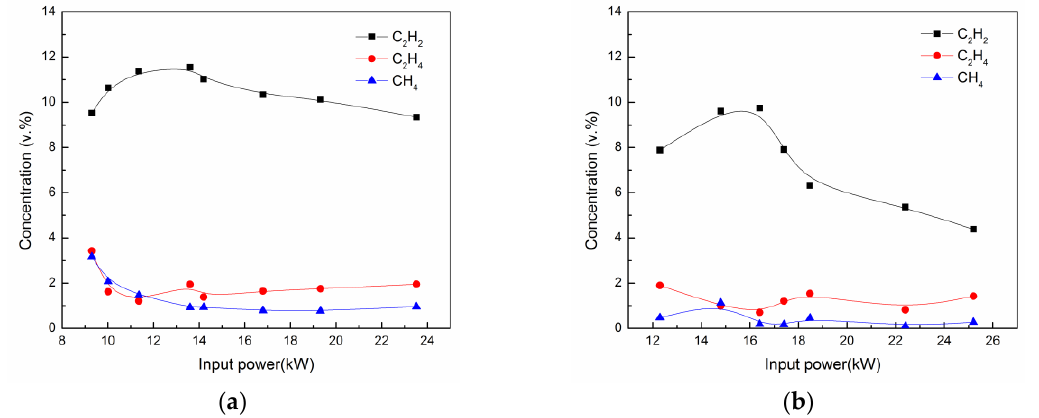
Figure 5 . The effect of power input on the concentration of C 2 H 2 , C 2 H 4 and CH 4 in the pyrolysis product of n- hexane ( a ) and toluene ( b ). Reaction conditions: ( a ) R H/C = 6.5, Q H m- n- hexane = 20.5 g/min, B = 0.058 T, P = 9.3–23.5 Kw; ( b ) R H/C = 6.5, 18.8 g/min, P = 12.3–25.2 kW, B = 0.058 T.